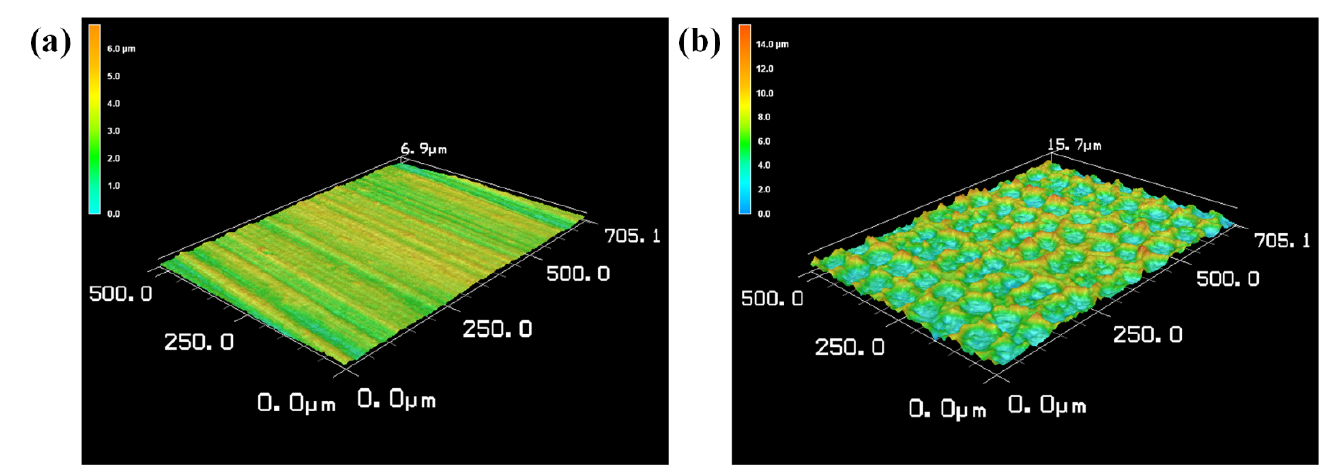
Figure 8. The top view micrograph of laser-cleaned and untreated surfaces: ( a ) untreated; ( b ) laser-cleaned.